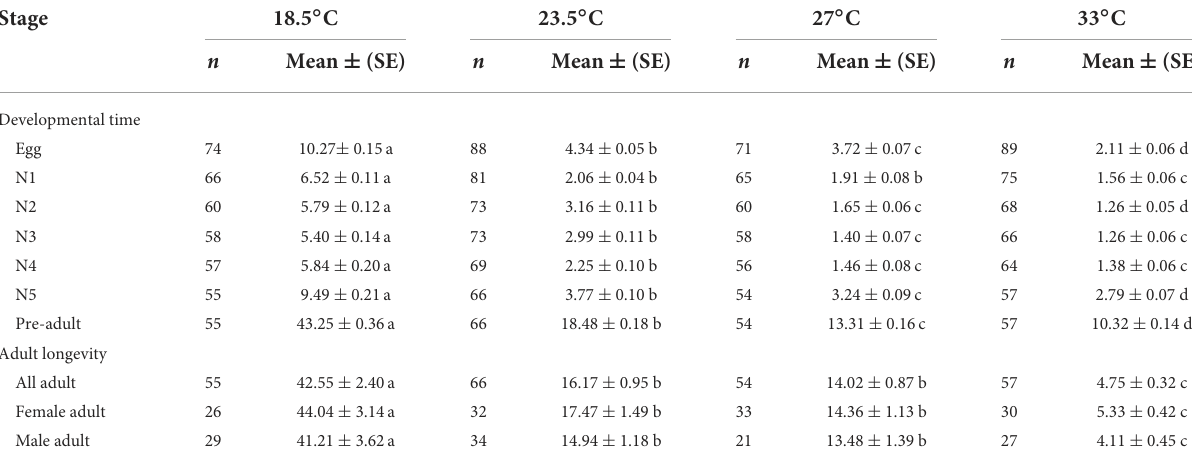
TABLE 1 Developmental times (d) and adult longevities (d) of Orius strigicollis fed on Frankliniella occidentalis at different temperatures. Stage